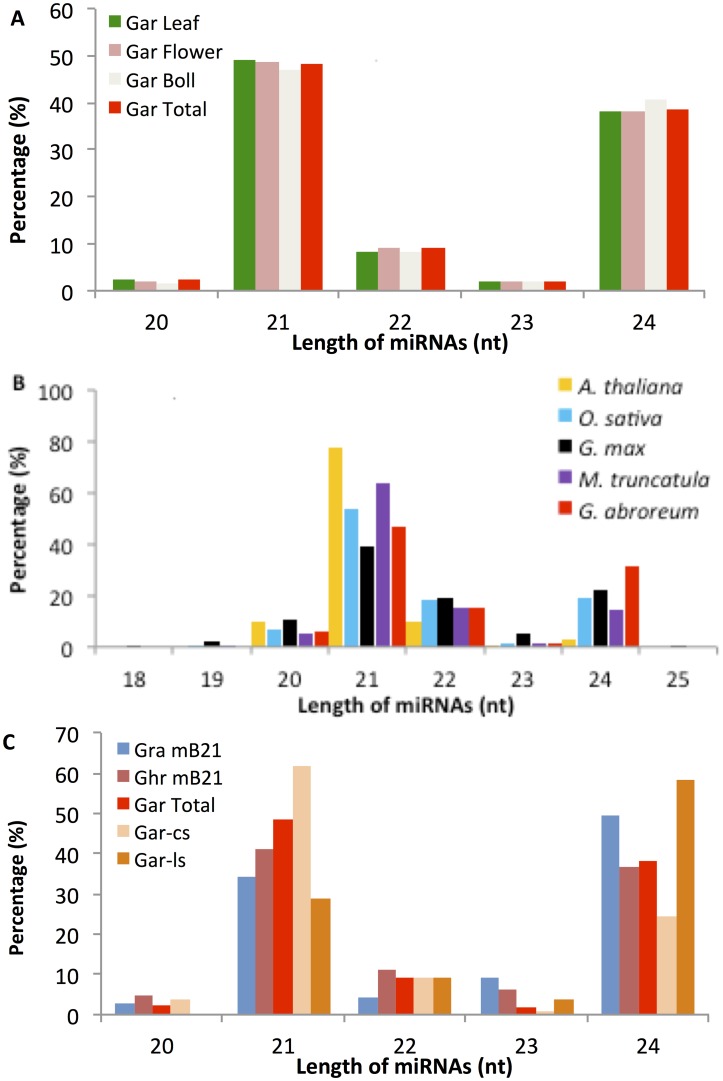
Length Distribution of G. arboreum predicted miRNAs compared to length distributions of other species species.Panel A. Comparison of the length distribution of mature miRNAs from each tissue-specific library with the G. arboreum total miRNAs. Panel B. The length distribution of miRNAs derived from G. arboreum compared to four representative model plant species, A. thaliana, Orysa. sativa (rice), Glycine max, Medicago truncatula (barrel medic) obtained from miRBase v21 are shown. Panel C. Comparison of the length distribution of G. arboreum total RNA or conserved or lineage specific G. arboreum miRNAs with the miRNAs found in miRBase v 21 from the genus Gossypium, in cluding G. raimondii (Gra) and G. hirsutum (Ghr).